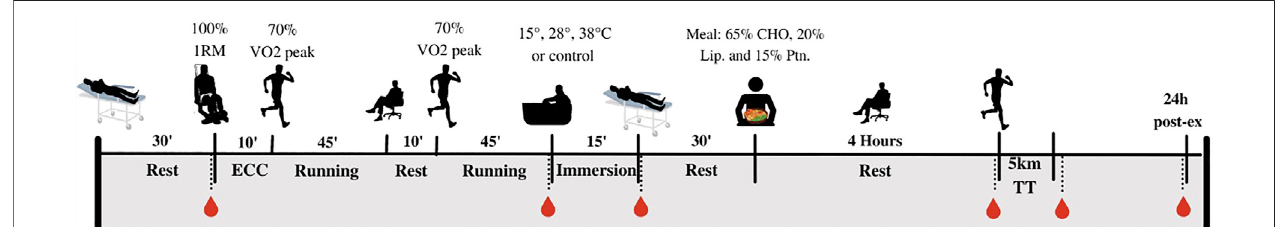
FIGURE 1 | Overview of the study